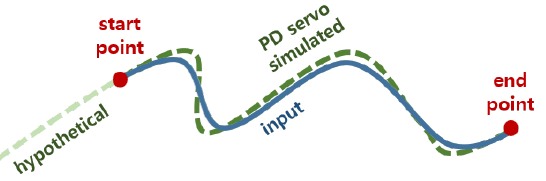
Figure 4. Path simulated by a proportional derivative (PD) servo on hypothetical and input